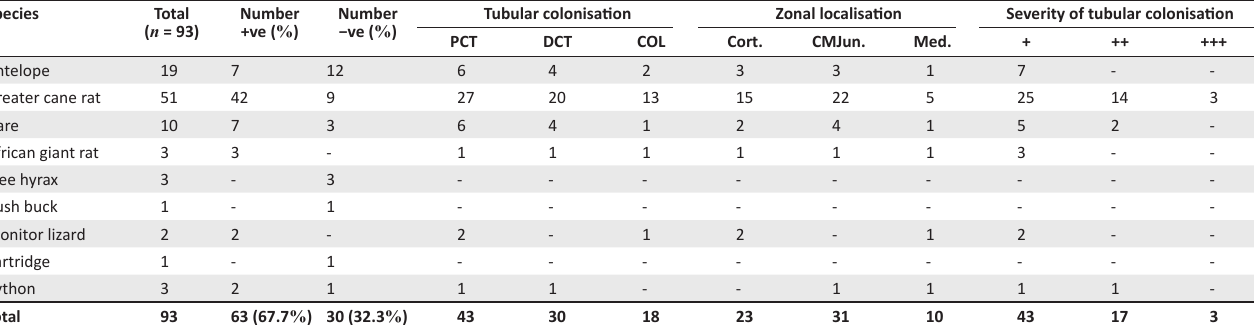
TABLE 5: Renal localisation and tubular colonisation of Leptospira organism in wildlife using Warthin–Starry silver stain. Species